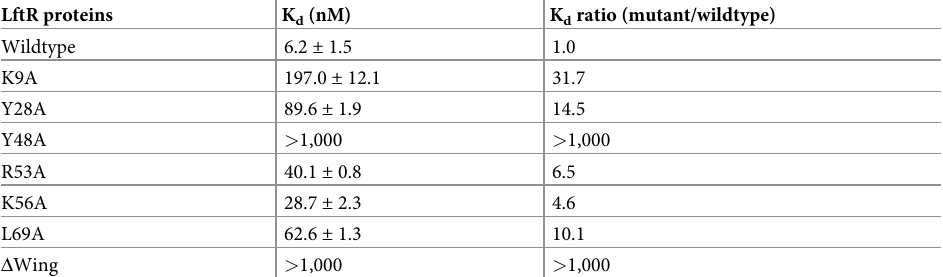
Table 1. Operator dsDNA-binding analysis of LftR wildtype and